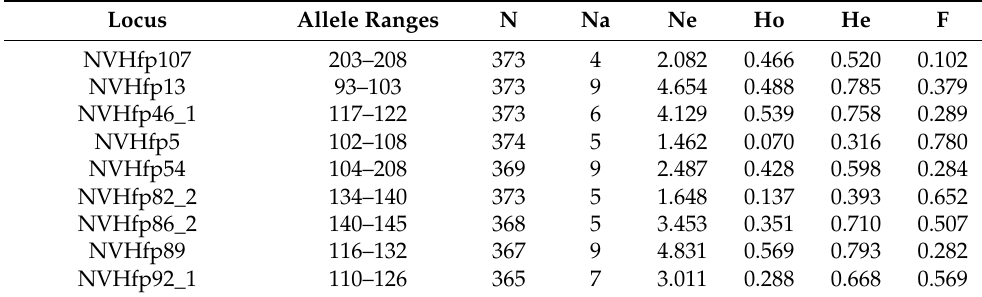
Table 1. Analysis of genetic variability for all samples. Locus Allele